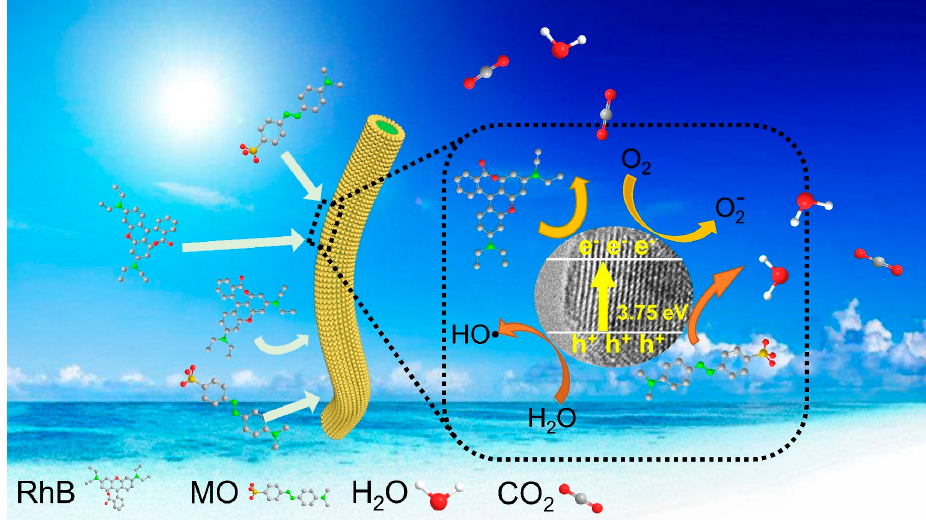
Figure 9. Photocatalytic degradation of MO or RhB by TQDs/CC photocatalyst.